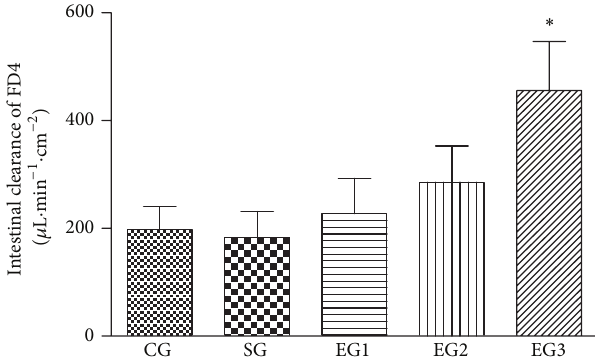
Figure 2: The intestinal clearance of FD4 in each group. CG = control group; SG = sham group; EG1 = exposure group with peri- toneal air exposure for 1h; EG2 = exposure group with peritoneal air exposure for 2 h; EG3 = exposure group with peritoneal air exposure for 3h. Values are expressed as mean ± SD. ∗ 𝑃 = 0.000 , compared with